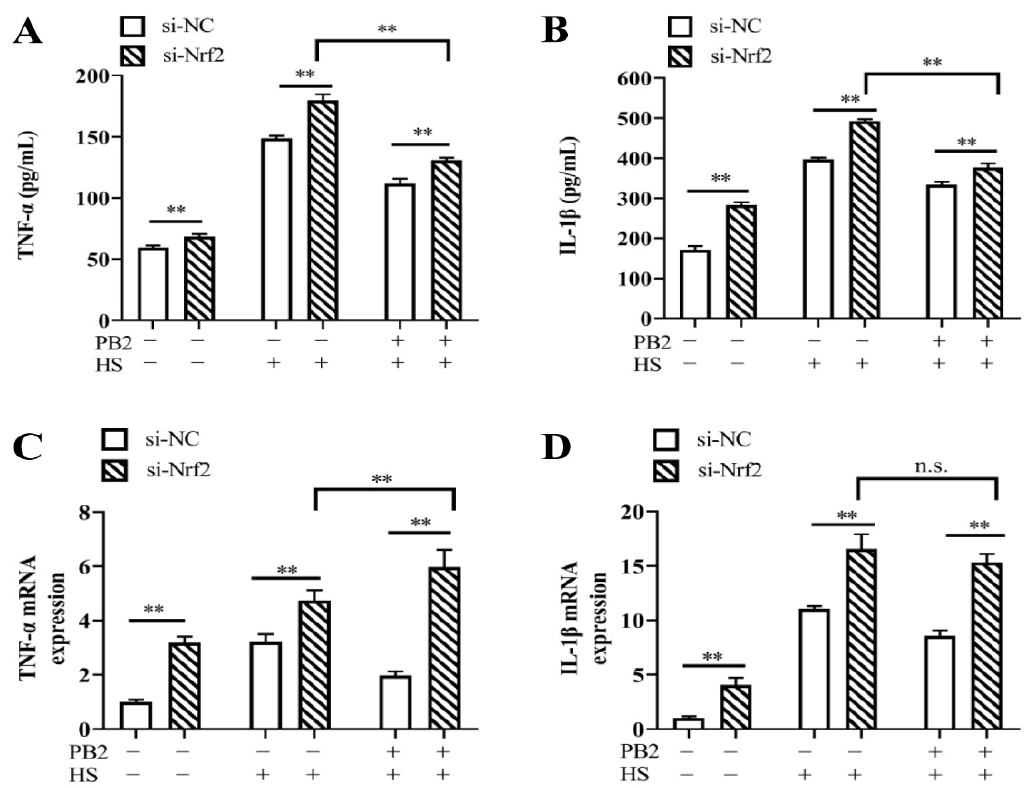
Figure 8. Effect of Nrf2 knockdown on release and gene expression of pro-inflammatory cytokines. MAC-T cells were transfected with si-Nrf2 or si-NC for 12 h, and then incubated with/without 25 µ M PB2 for 24 h, followed by HS treatment for 3 h and recovery for 6 h. Then, the culture media were used to investigate the release of ( A ) TNF- α and ( B ) IL-1 β , and cells were harvested to test ( C ) TNF-α and ( D ) IL ‐ 1 β mRNA expression levels. n = 3. ** p < 0.01, n.s. p > 0.05.